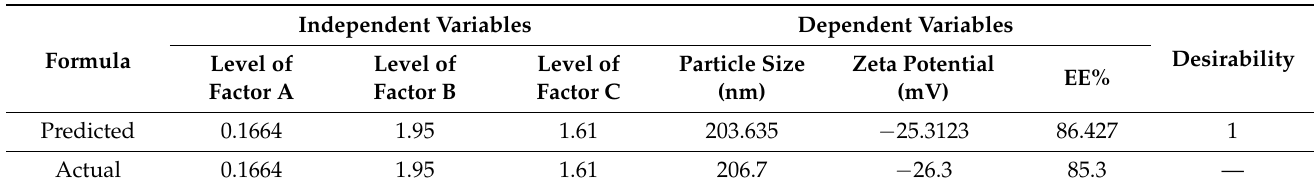
Table 5. Predicted and actual values of independent variables and responses for the optimized formulation.